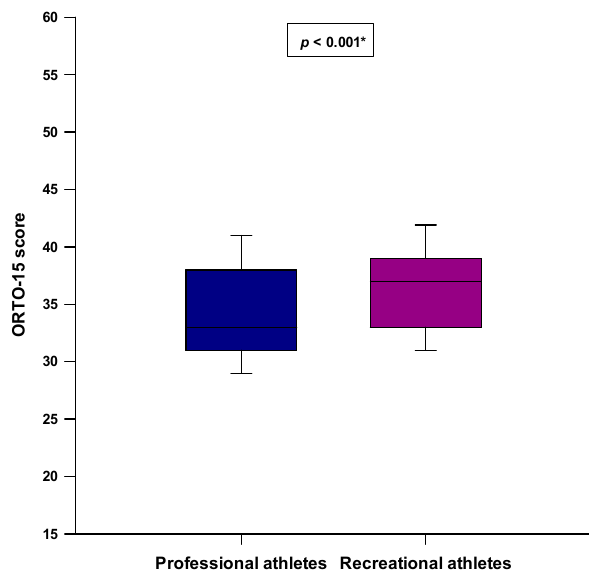
Figure 3. Difference in the ORTO-15 score between the professional athlete ( N = 150) and recreational athlete groups ( N = 150). * Mann–Whitney U